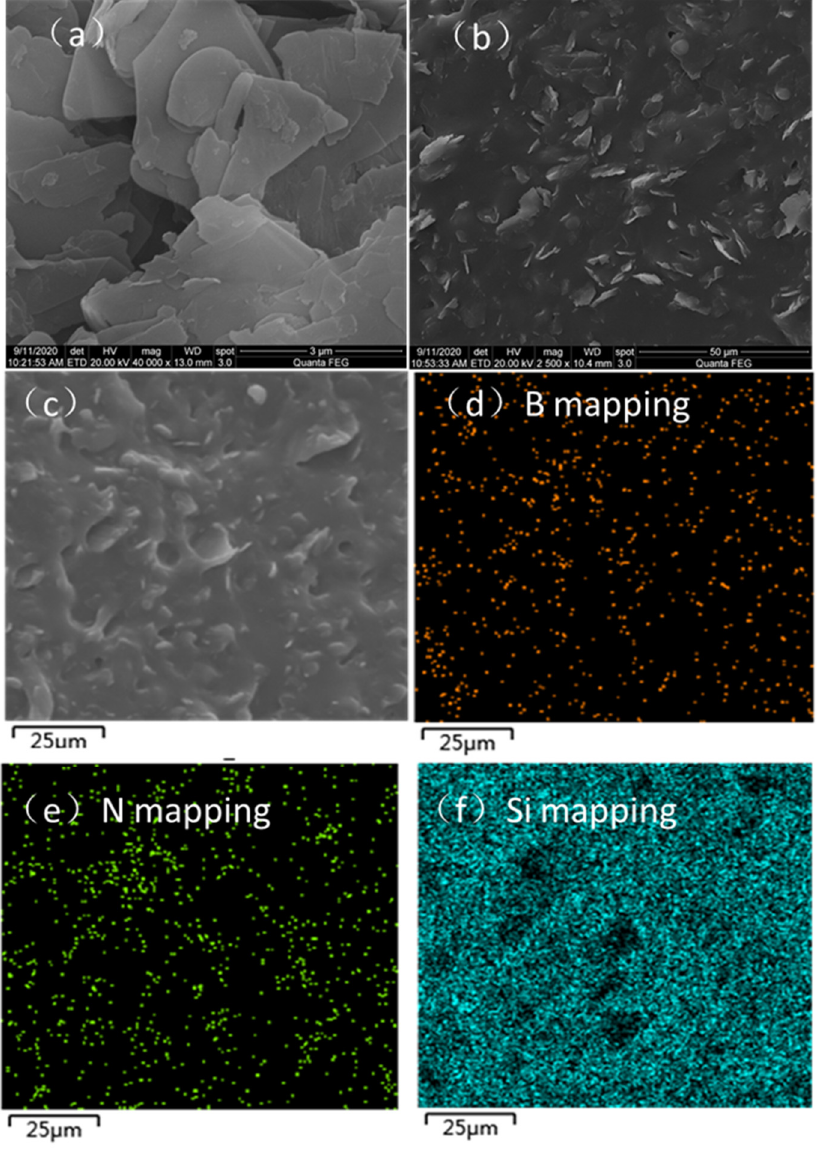
Figure 5. SEM images: ( a ) morphology of h-BN, ( b , c ) morphologies of h-BN/SR composite with different magnifications, and ( d – f ) corresponding B, N, and Si element mappings.